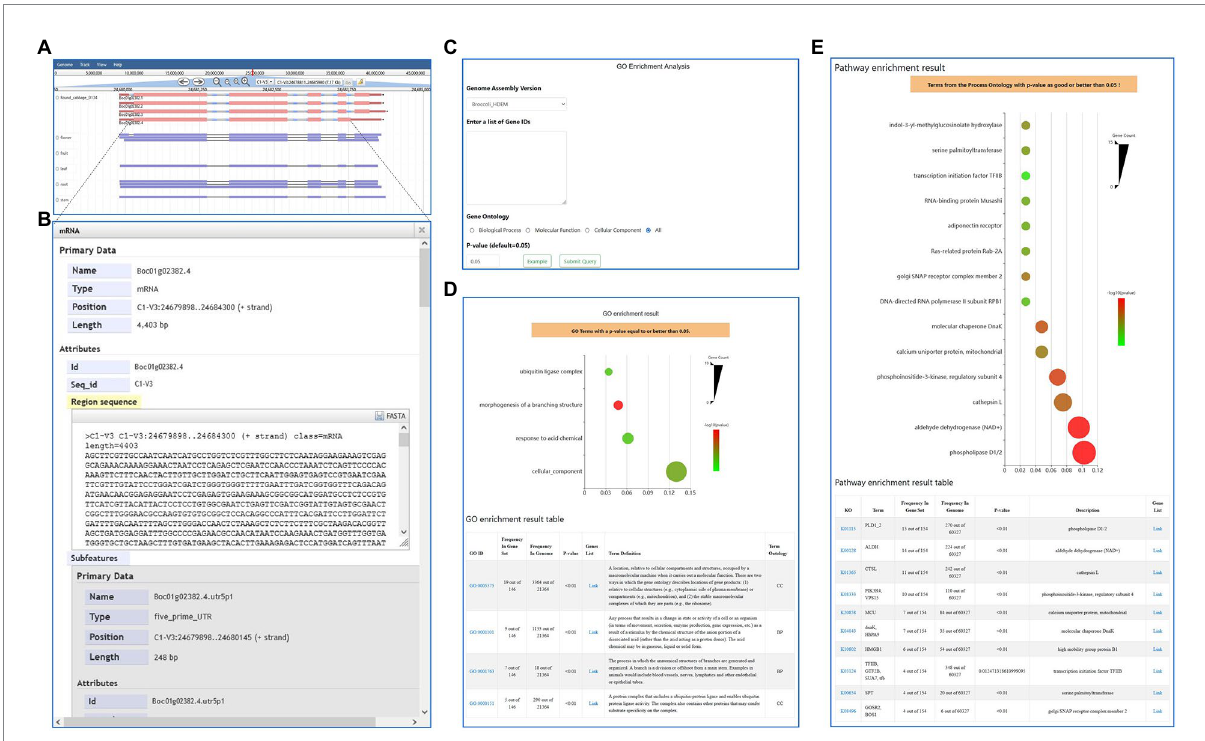
FIGURE 4 The “Genome Browser” module and GO/KEGG tools. (A,B) The “Genome Browser” module provides genomic data, including gene structure, gene location, and genome and transcript sequences. (C,D) The “GO Enrichment” shows enriched GO terms within a query gene list. (E) The “KEGG Enrichment” shows enriched KO terms within a query gene